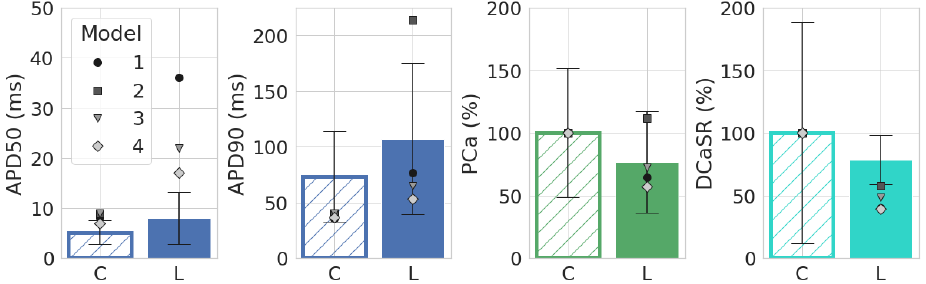
Figure 4. Comparison of AP duration at the level of 50% (APD50), 90% (APD90), calcium transient peak (PCa), and diastolic SR Ca 2 + (DCaSR) in Models 1–4 with experimental data from [12]. Simula- tions for BCL = 500 ms; boxplots (mean ± STD) are experimental results from [12]. The differences between leptin-treated and control groups shown in the experiment were statistically significant ( p -value was <0.001 for APD50, APD90, and DCaSR and <0.05 for PCa)